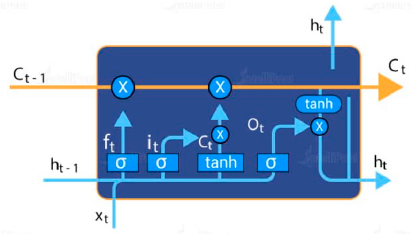
Figure 1. LSTM cell.